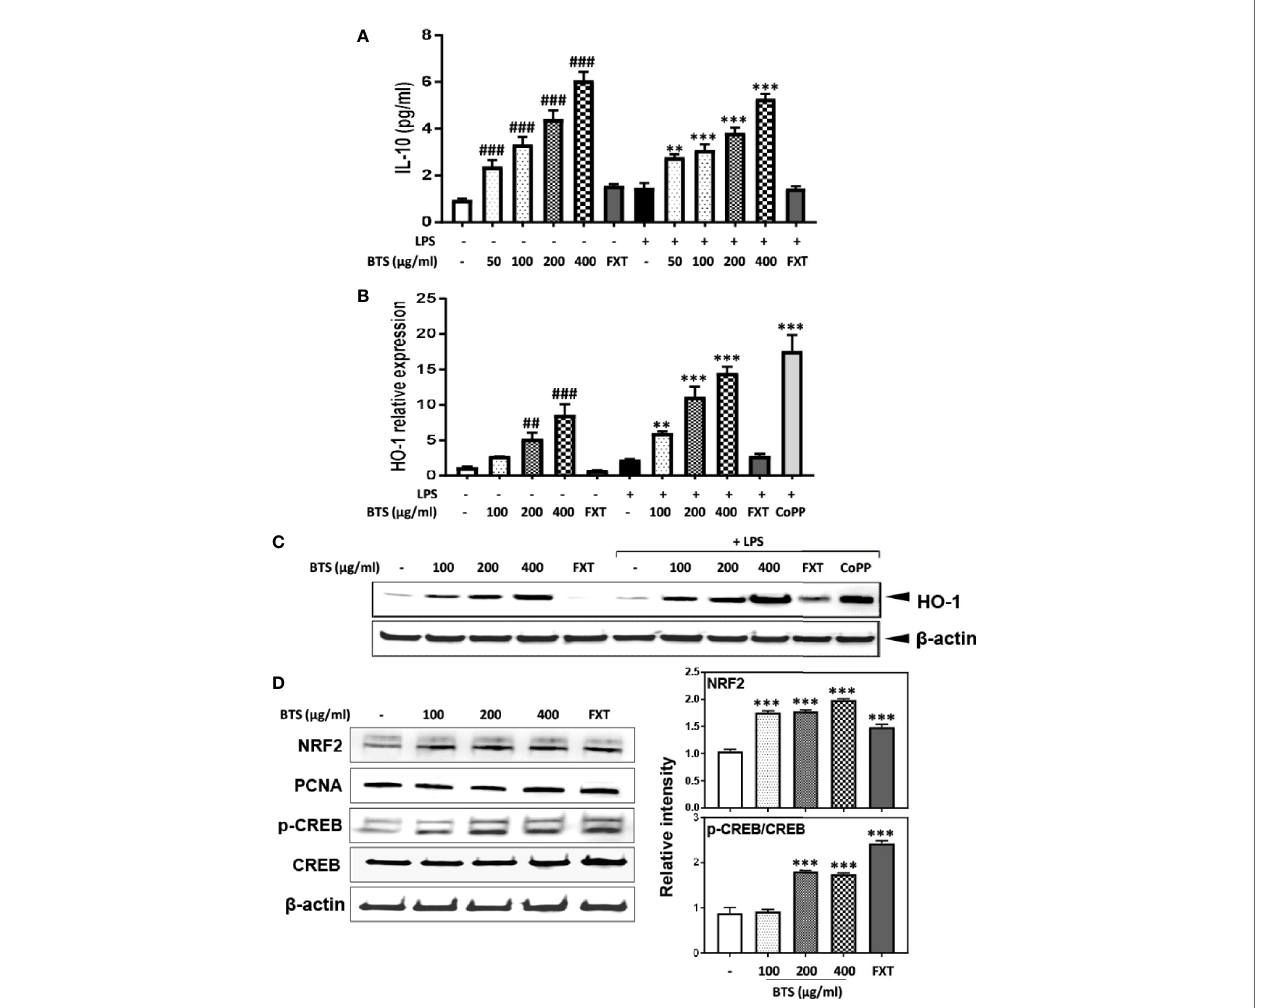
FIGURE 8 | Effect of BTS on IL-10 production and HO-1 expression in BV2 cells. (A) BV2 cells were pretreated with BTS for 1 h and then stimulated with LPS (100 ng/ml) for 16 h. Levels of IL-10 in the cell culture supernatant were measured by ELISA. (B) BV2 cells were pretreated with BTS for 1 h and then stimulated with LPS (100 ng/ml) for 6 h. Hmox1 mRNA levels were determined by real-time PCR. Gapdh was used as a loading control. (C) BV2 cells were pretreated with BTS for 1 h and then stimulated with LPS (100ng/ml) for 12 h. The level of HO-1 was determined by western blotting. b -actin was used as a loading control. (D) BV2 cells were pretreated with BTS for 6 h, and nuclear extracts were analyzed by western blotting using an NRF2 antibody. PCNA was used as a loading control. BV2 cells were pretreated with BTS for 30 min, and levels of p-CREB and CREB were determined by western blotting. b -actin was used as a loading control. The data represent three independent experiments. The data are expressed as the mean ± SD of triplicate determinations (one-way ANOVA: ## p < 0.01, ### p < 0.001 vs. untreated control; **p<0.01, ***p < 0.001 vs. LPS-treated